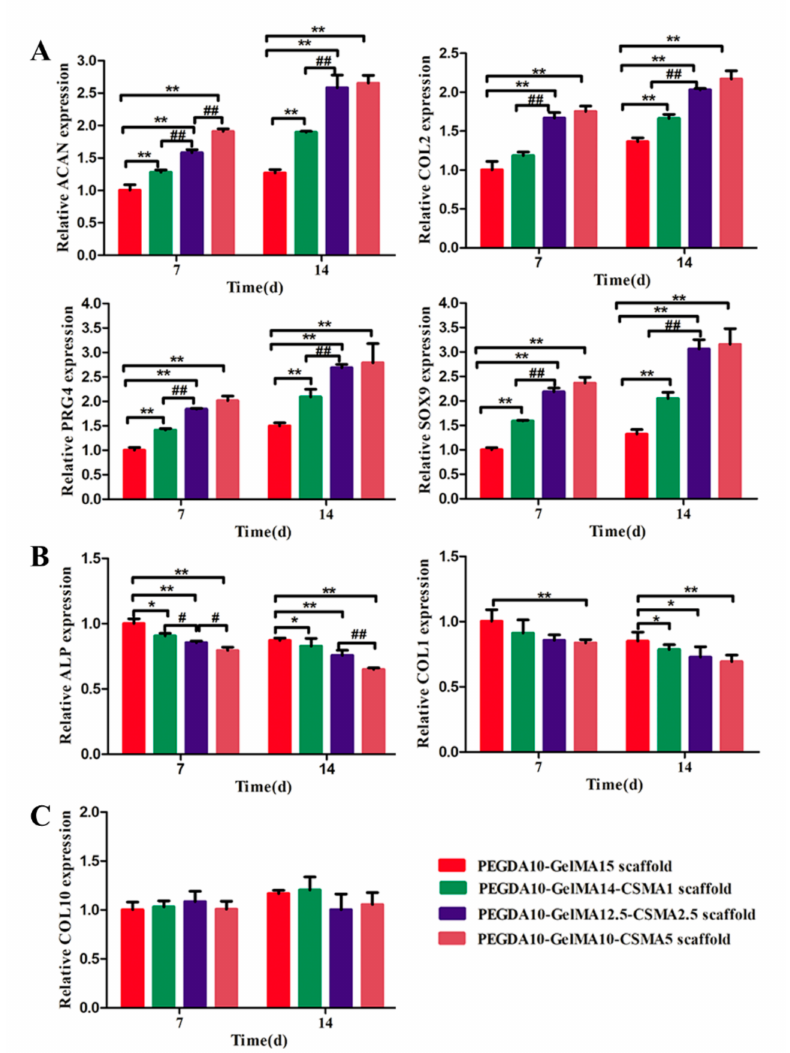
Figure 4. RT-PCR analysis. ( A ) The expression of cartilage-specific genes (ACAN, COL2, SOX9, and PRG4) and ( B ) osteogenesis marker gene (ALP and COL-1). ( C ) hypertrophic gene COL-10 of BMSCs within various scaffolds determined by RT-PCR tests on day 7 and 14 ( n = 3; * p < 0.05, # p < 0.05, ** p < 0.01, ## p <